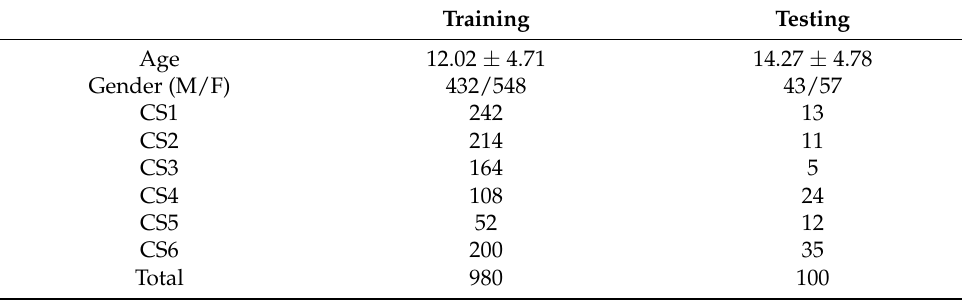
Figure 1. The experimental design of the study. Step 1: inclusion and exclusion. Step 2: data pre-processing. Step 3: model training and testing. Step 4: performance evaluation. Table 1. The age, gender and CVM staging distribution of the